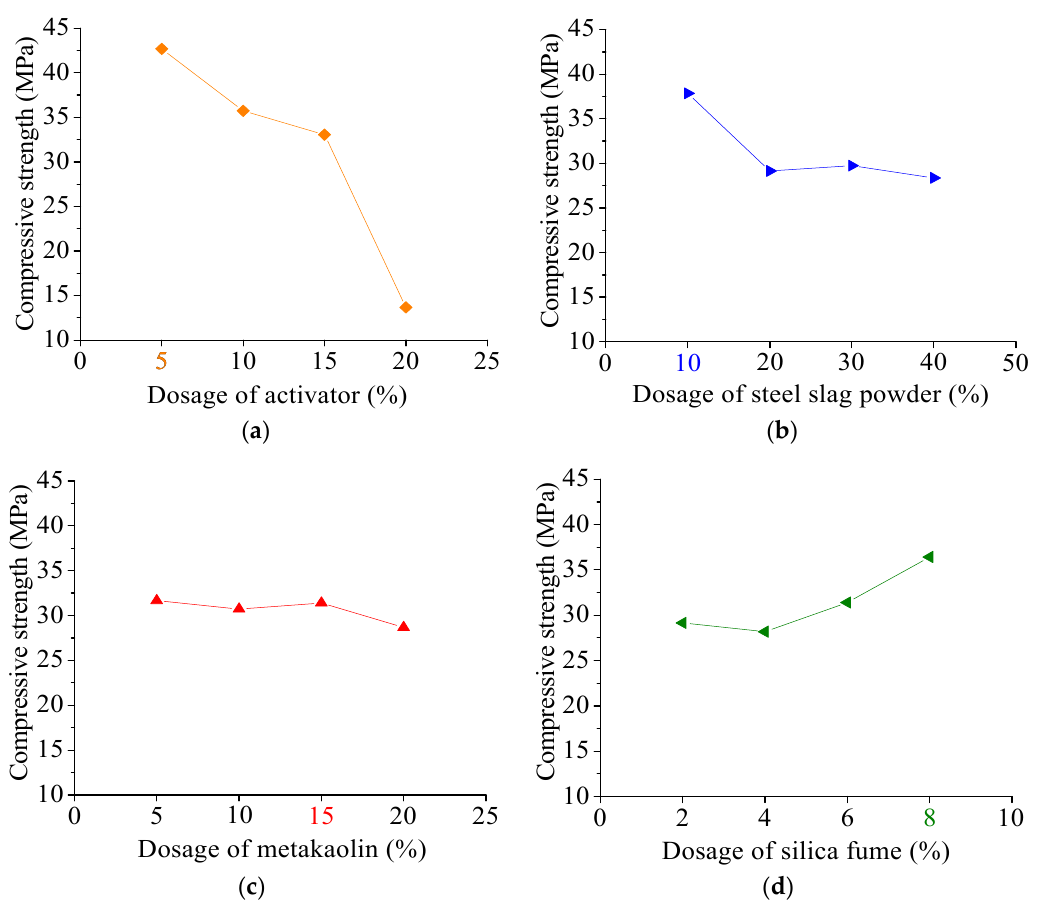
Figure 5. Relationship between compressive strength and dosage levels of each factor: ( a ) activator; ( b ) steel slag powder; ( c ) metakaolin and ( d ) Silica fume.